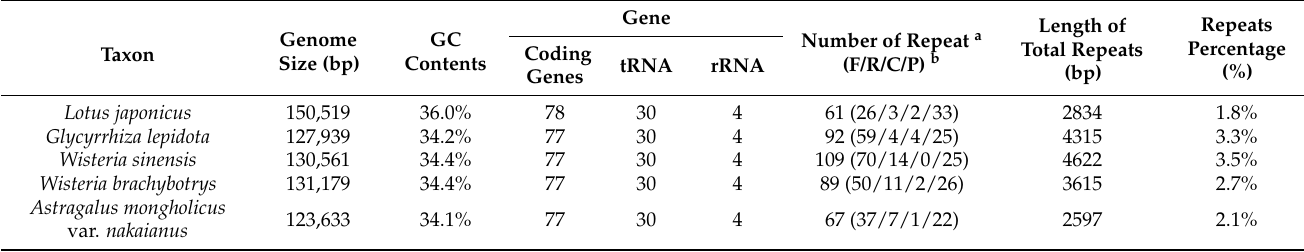
Figure 1. The complete chloroplast genome of Gueldenstaedtia verna . The genes are transcribed clockwise on the inside and counterclockwise on the outside. The darker gray in the inner circle corresponds to the GC content. Table 1. Characters of 15 inverted repeat-lacking clade (IRLC) species and 1 legume species (LS, Lotus japonicus